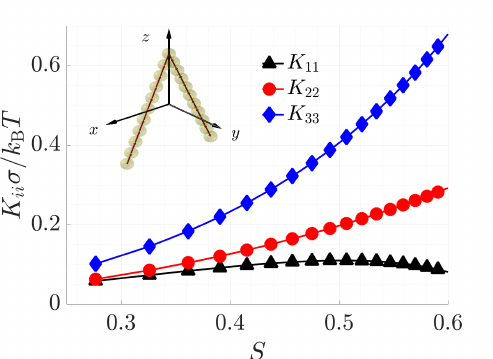
Figure 6. Elastic constants calculated for acute angle V-shaped with a bend angle χ = 45 ◦ (see inset), as a function of the order parameter S